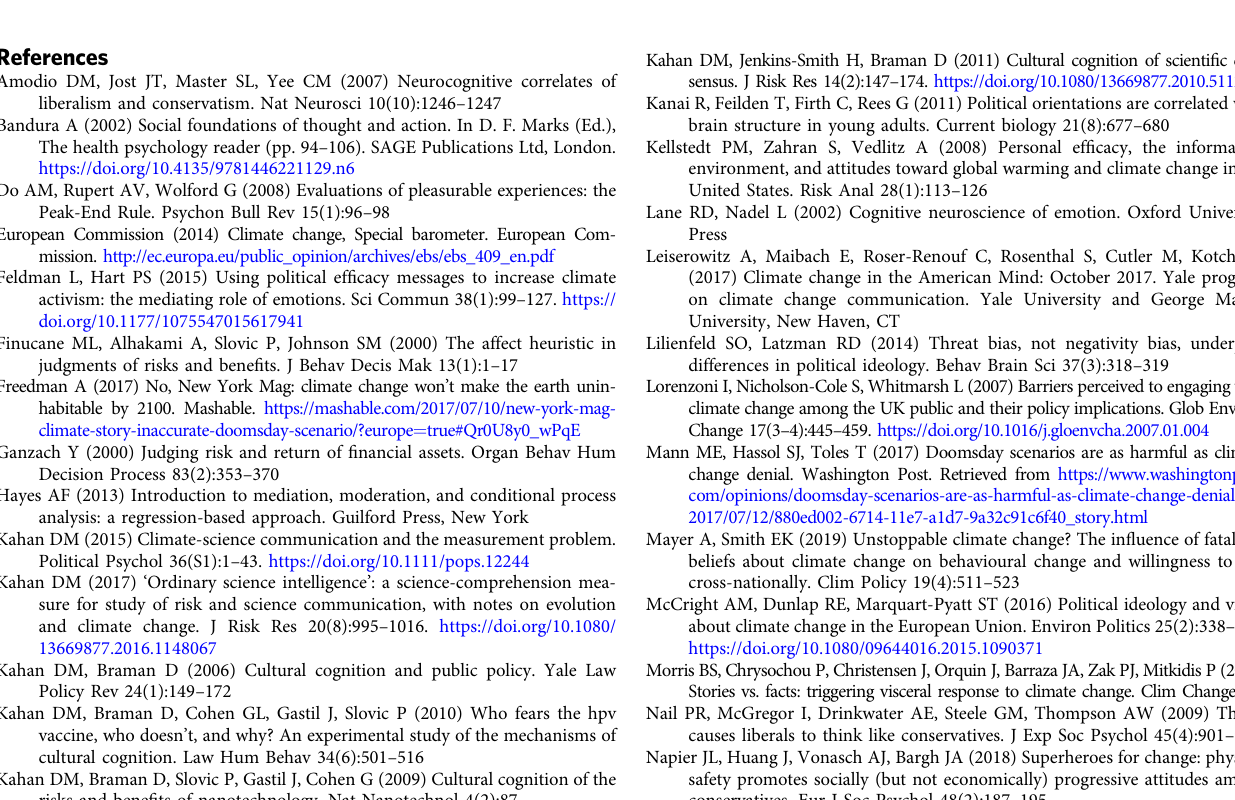
Fig. 3 Violin plots of experienced emotional arousal by condition and political ideology, Studies 1 – 3. Black dots represent means; error bars indicate standard